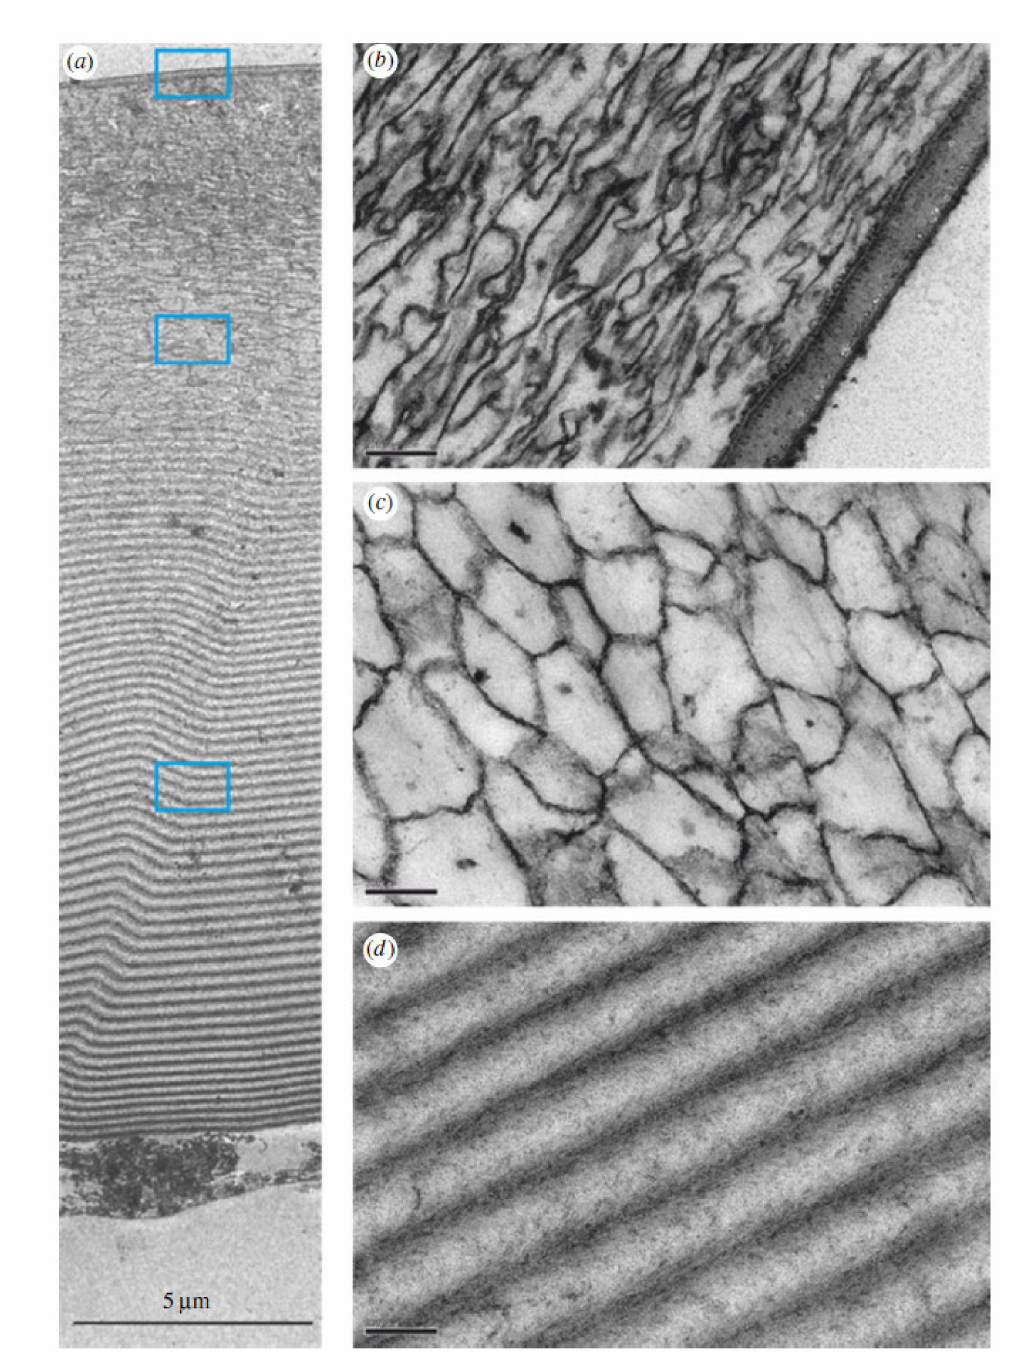
Figure 2. Cross-section of the window of the carapace of Macrocypridina castanea , 100 nm thick, stained with uranyl acetate and lead citrate, outermost region at the top, transmission electron micrographs (note a slight distortion in the sample). ( a ) Whole section of the shell. ( b – d ) Magnifications of the three selected regions in ( a ), shown by rectangles. Scale bars, 5 µ m ( a ), 200 nm ( b – d ). Reproduced from Parker et al. [6], with permission from The Royal Society,